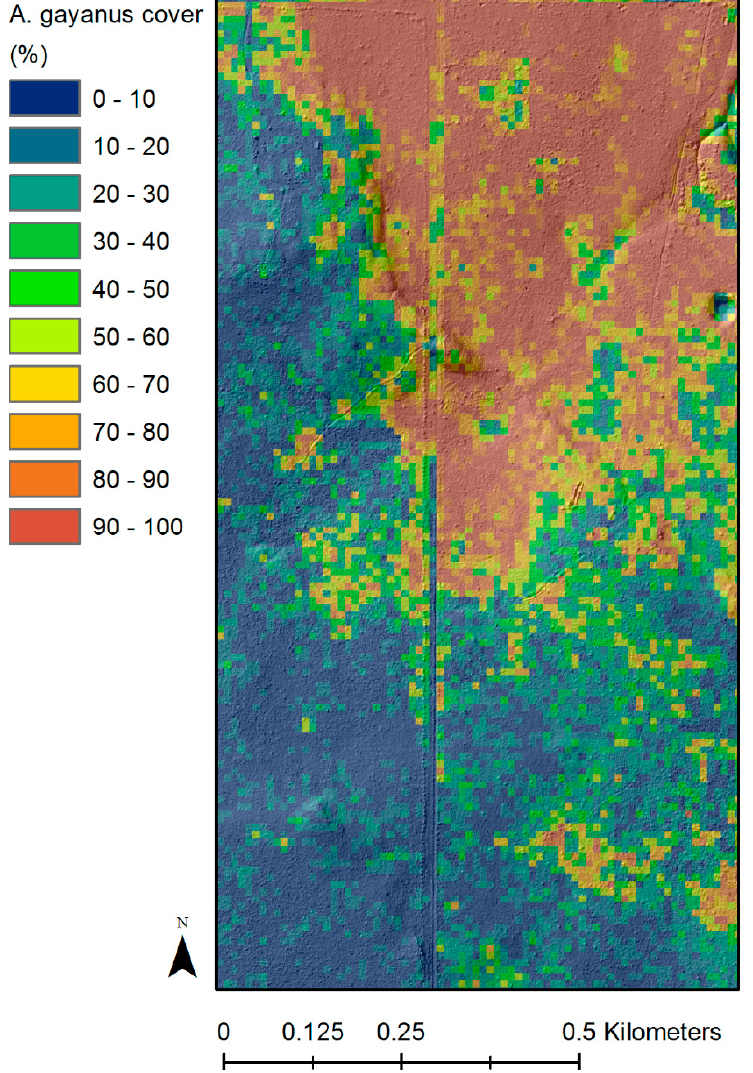
Figure 8. Spatial variability of A. gayanus cover mapped using airborne LiDAR showing the advancing invasion front in the region adjacent to Litchfield National Park,